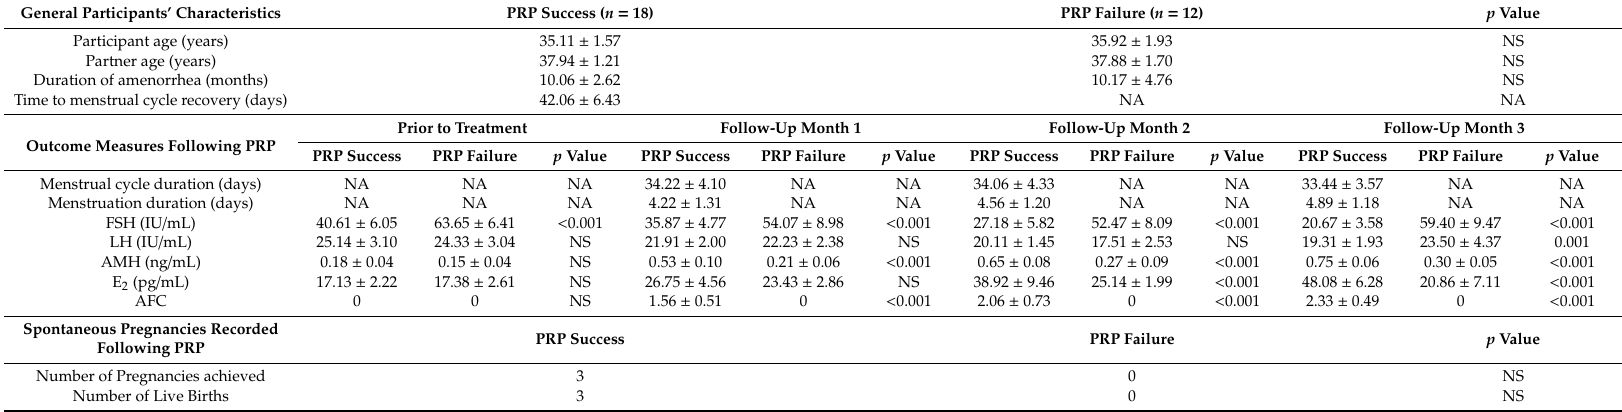
Table 3. Statistical analysis and outcome assessment prior and following PRP intraovarian infusion regarding the Premature Ovarian Insu ffi ciency pilot study. General Participants’